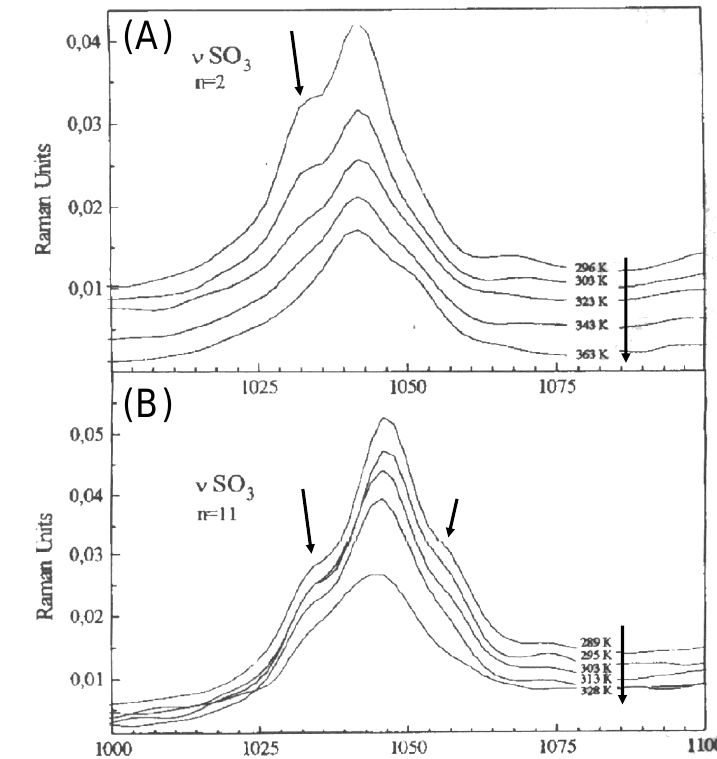
Figure 3. Raman spectra of dimethyl ethylene glycol with the chain lengths 2 ( A ) and 11 ( B ) (EG) DME and (EG) DME and EO/Li = 10 inverse molar ratio of LiCF 2 11 elements of ethylene oxide oligomer in a temperature range of 289 K to 363